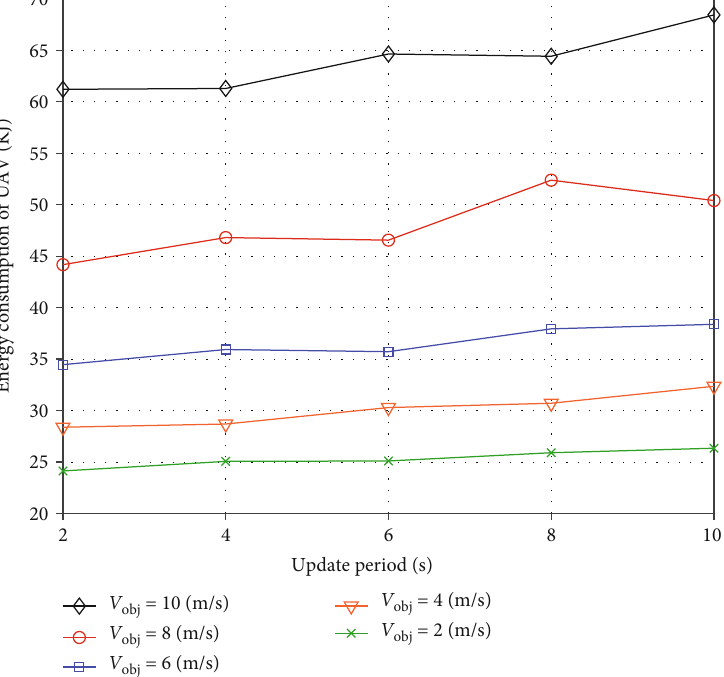
Figure 12: Energy consumption on searching — object movement again has more apparent impact than update period